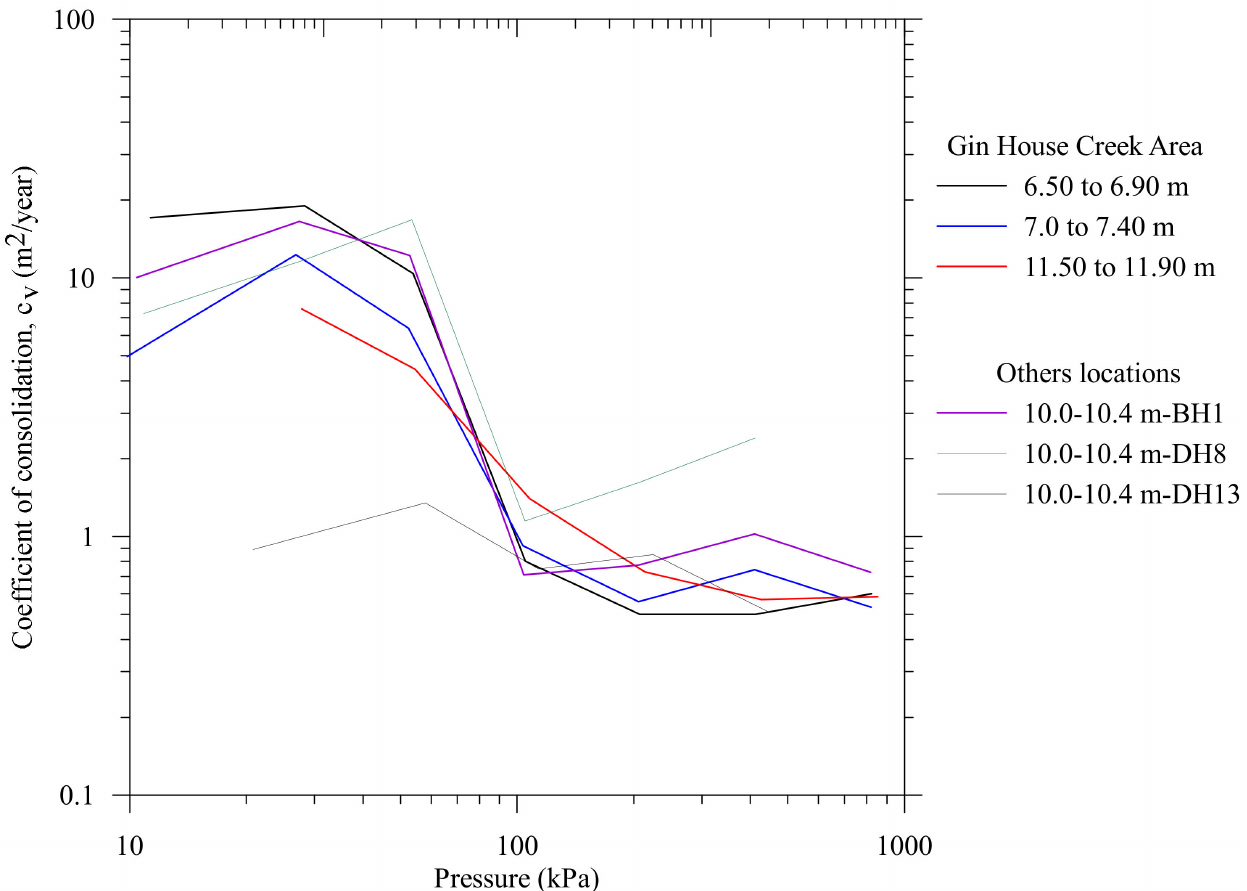
Figure 18. Measured vertical consolidation coefficient of the NBR embankment